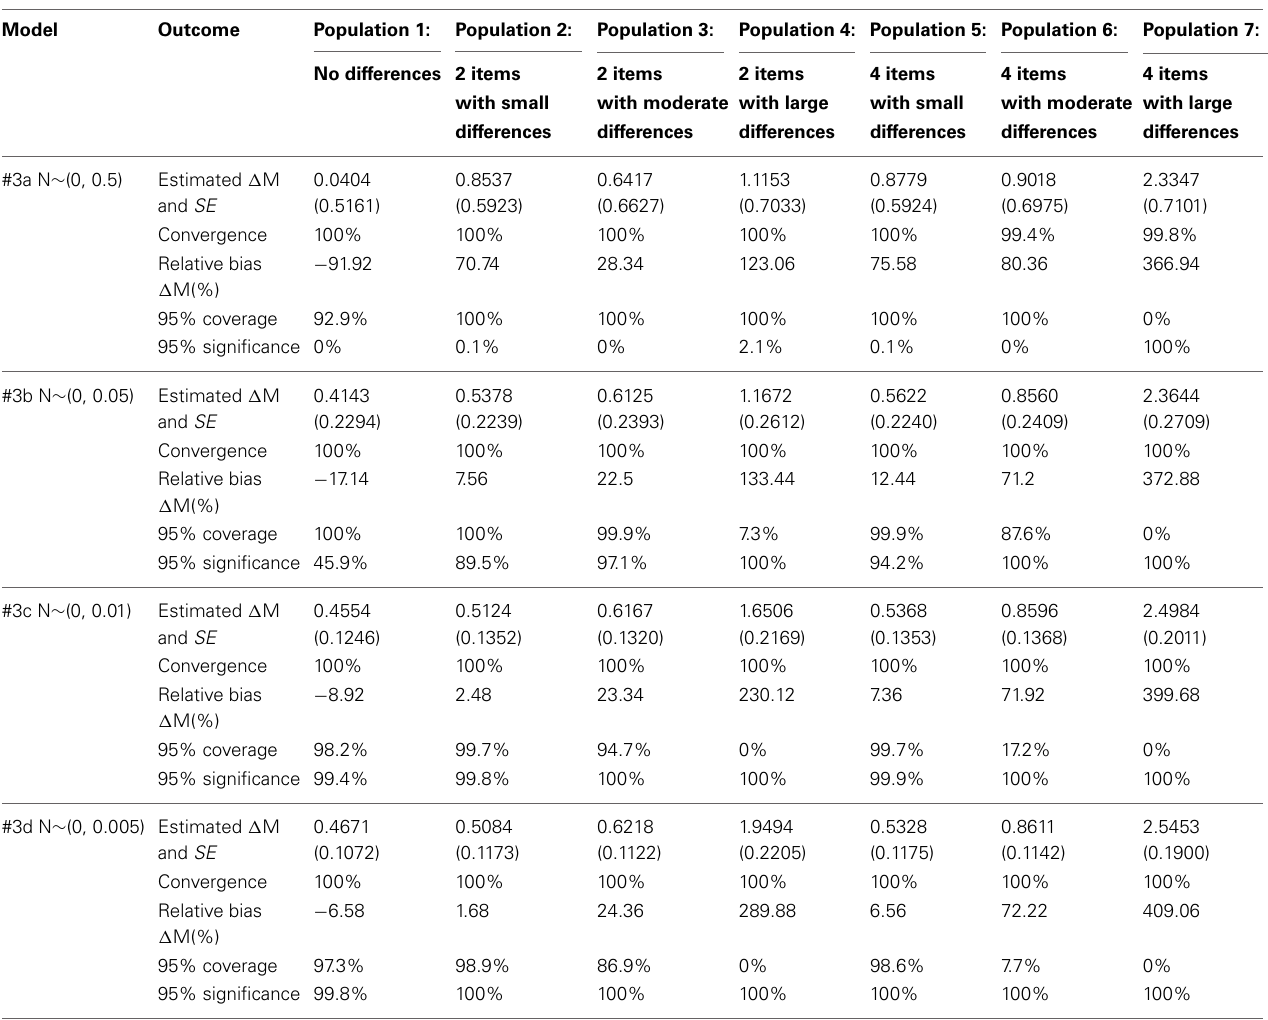
Table 5 | Simulation results for Model 3.